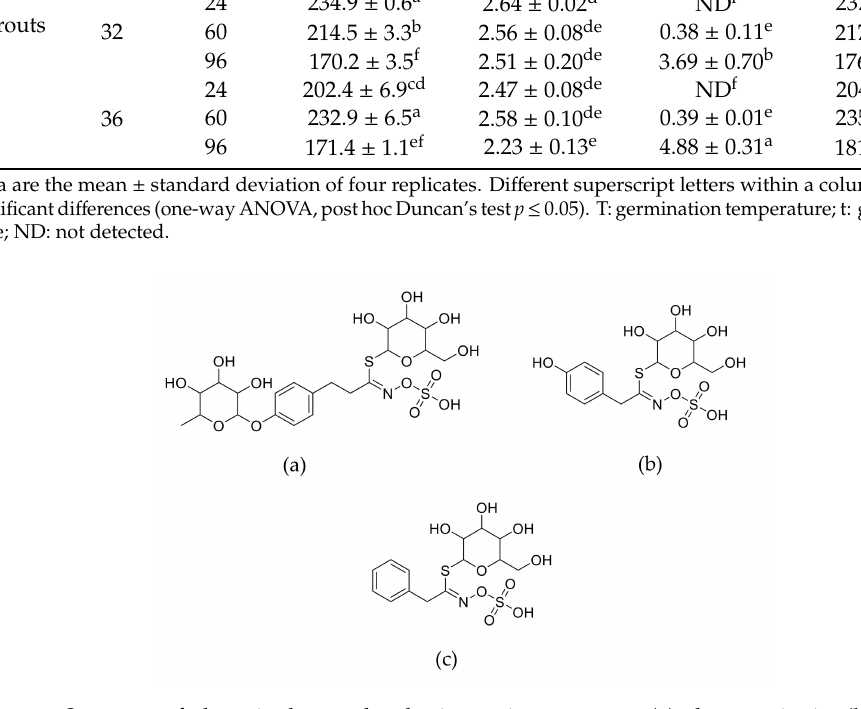
Figure 2. Structure of glucosinolate molecules in moringa sprouts. ( a ) glucomoringin; ( b ) sinalbin; ( c )